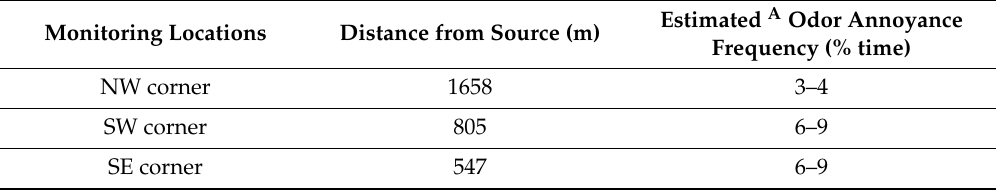
Table 2. Odor annoyance estimated by SDOFT for the dairy case study based on distance from the source.